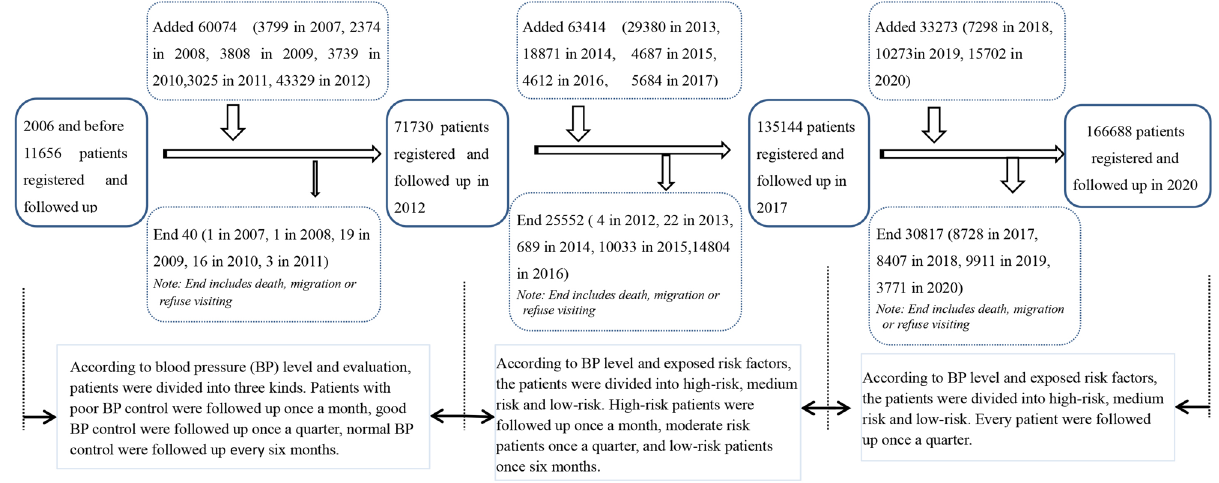
Figure 1. Dynamic changes of follow-up management cohort of hypertension in Jiading